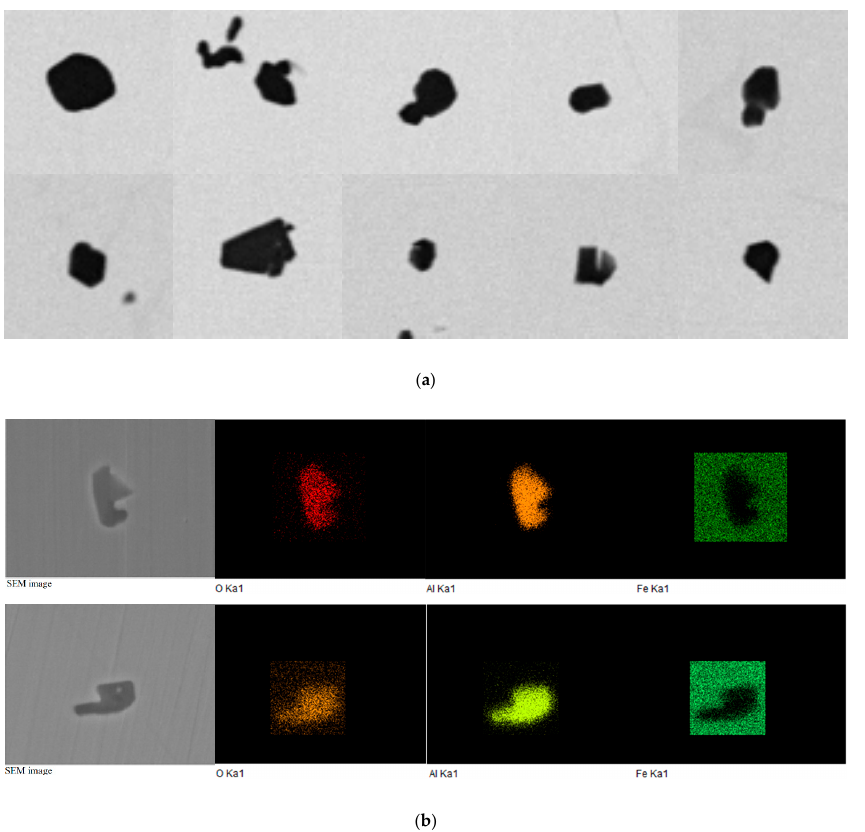
Figure 6. SEM-EDS image of Al 2 O 3. ( a ) SEM image of Al 2 O 3. ( b ) EDS image of Al 2 O 3.